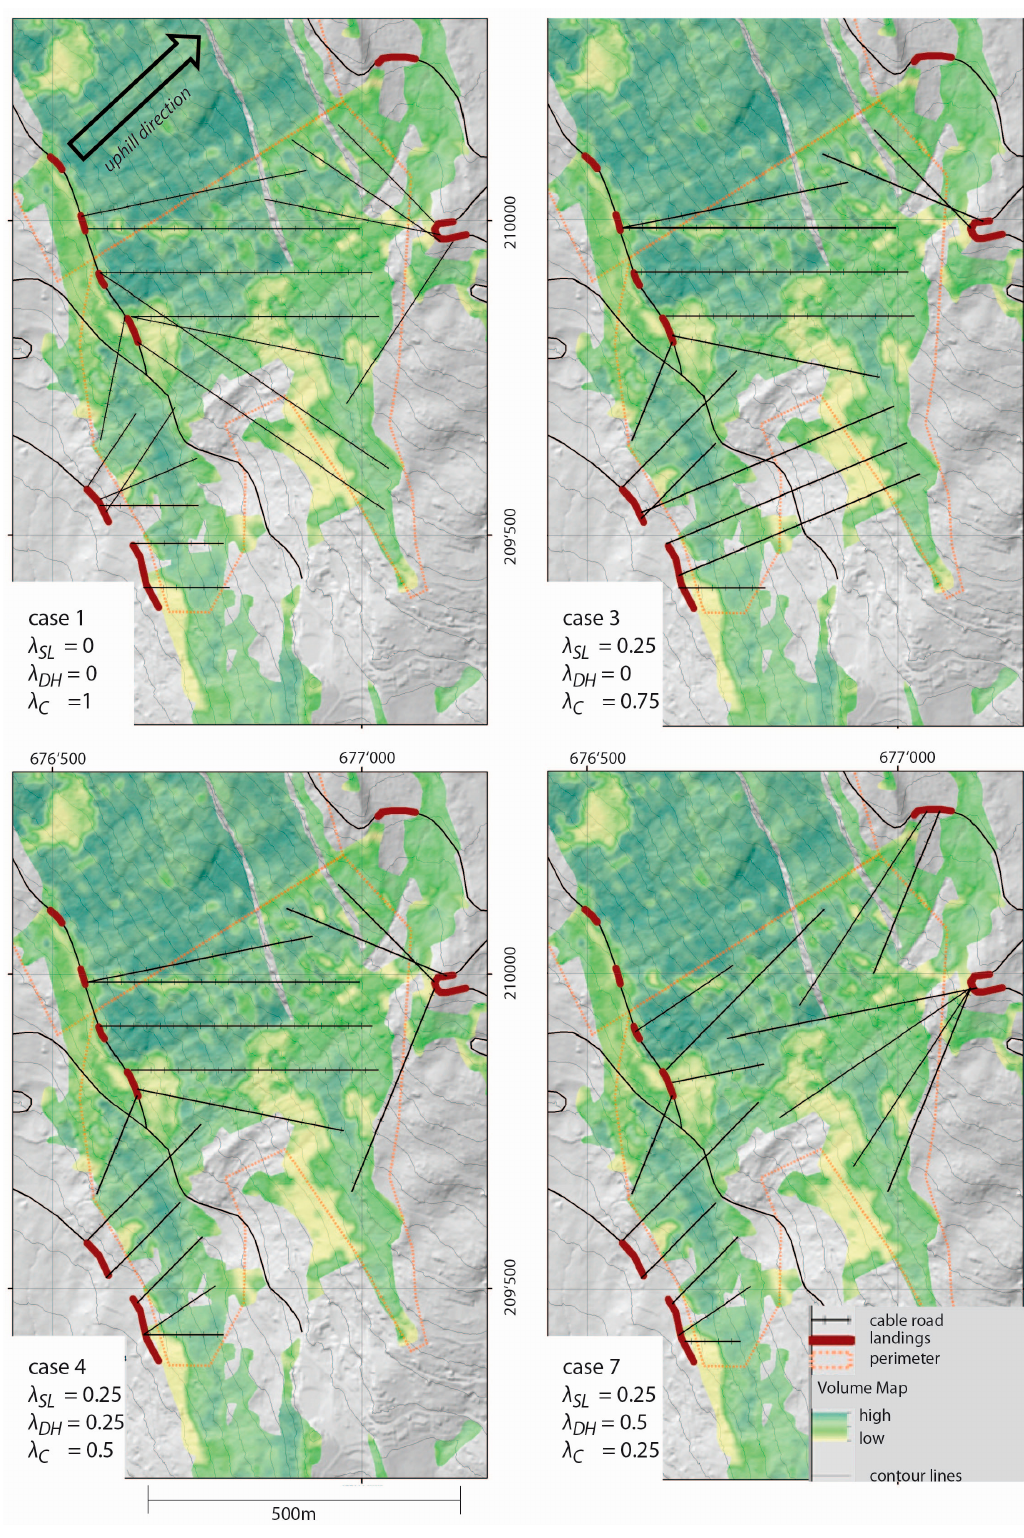
Figure 7. CR and harvesting layouts of weighting cases 1, 3, 4, and 7 (with f H = 0.7) for area 01. The corresponding properties of those layouts can be found in Table 6.